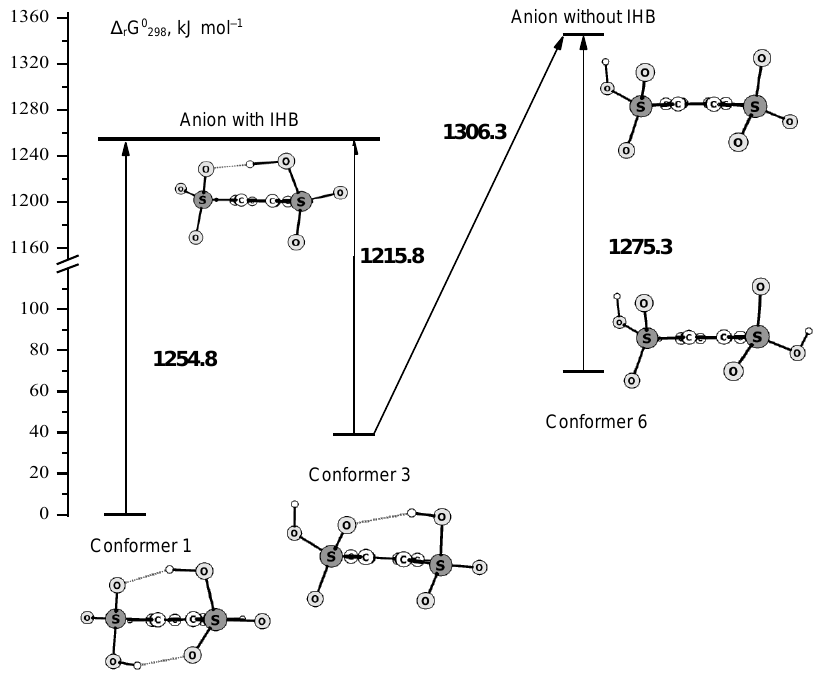
Table 5. Gibbs energies of GD of different conformers 2-SO 3 H-BSA (kJ mol −1 ) in two stages.